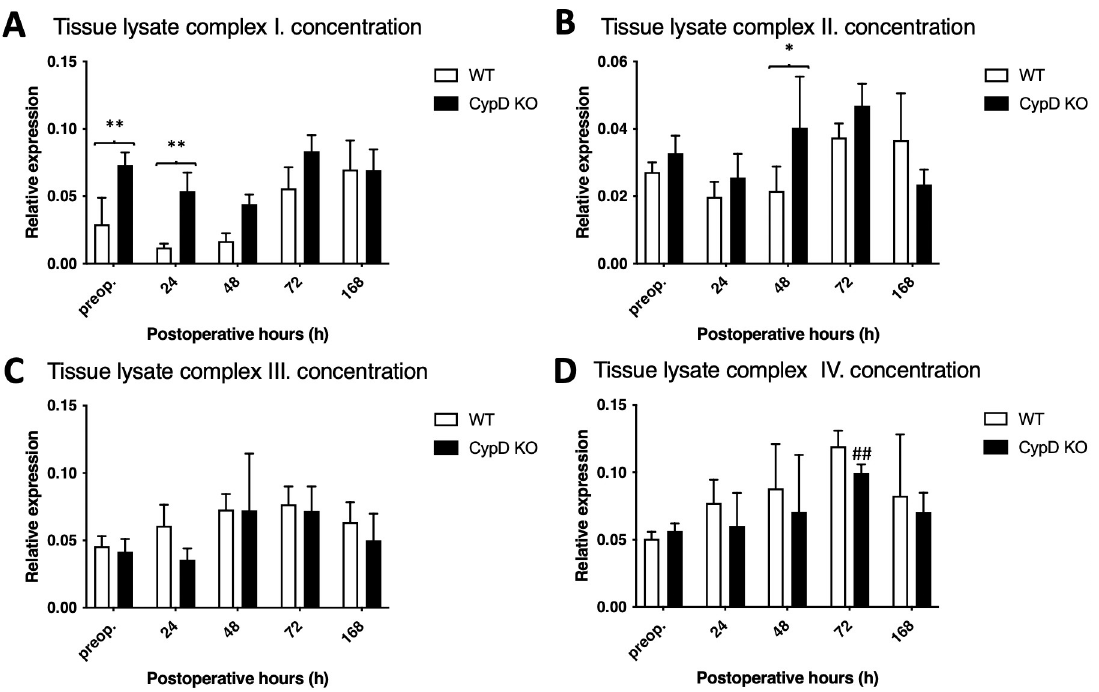
Fig 5. Changes in the expression of the respiratory chain complexes. Complex I (A), complex II (B), complex III (C), complex IV (D) total cell lysate protein concentrations preoperatively (preop., 0 h), and at 24 h, 48 h, 72 h, and 168 h after Associating Liver Partition and Portal vein ligation for Staged hepatectomy (ALPPS) (N = 6 per time point per group). � P < 0.050, �� P < 0.0010 versus wild type (WT); # P < 0.050, ## P < 0.001 WT versus corresponding controls (preop.); § P < 0.050, §§ P < 0.0010 CypD KO versus corresponding controls (preop.). Statistical analysis was performed with a two-way ANOVA and Tukey’s post hoc test.